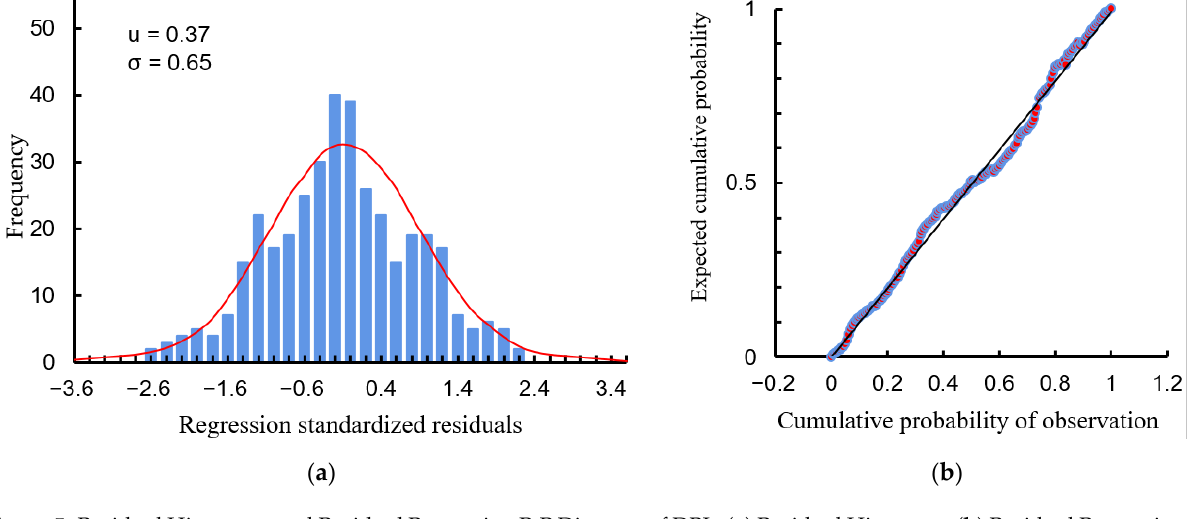
Figure 5. Residual Histogram and Residual Regression P-P Diagram of DBL. ( a ) Residual Histogram ( b ) Residual Regression P-P Diagram.